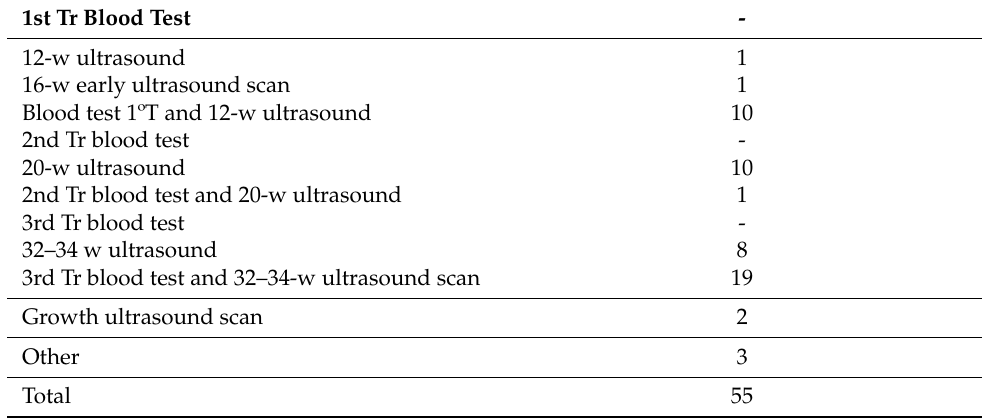
Table 2. Detail of procedures performed during in-person visits.